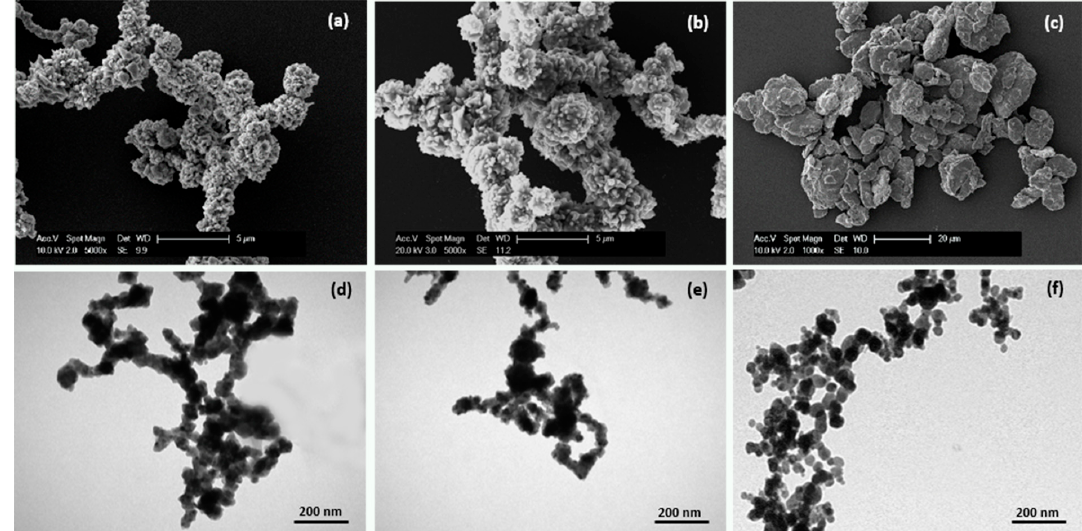
Figure 1. Scanning electron microscopy images of metal microparticles deposited on a glass coverslip: Fe ( a ), Co ( b ), and Ni ( c ) and transmission electron microscopy images of metal nanoparticles deposited on formvar carbon-coated grids: Fe ( d ), Co ( e ), and Ni ( f ). Certain heterogeneity in the size and shape is observed for all the particles.